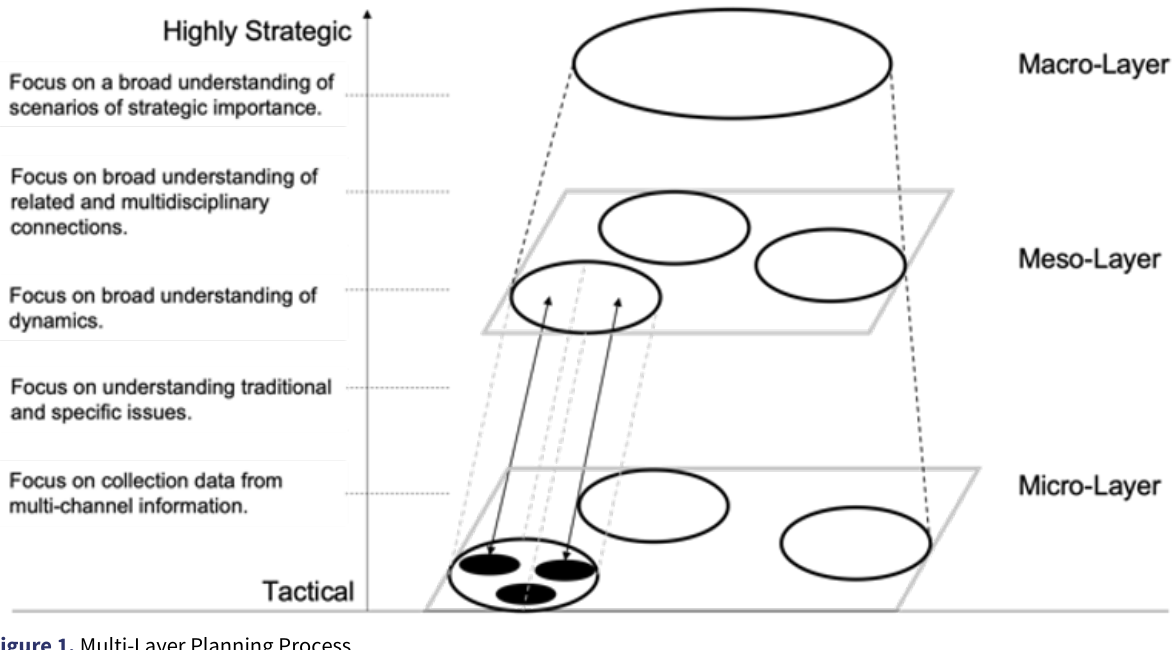
Figure 1. Multi-Layer Planning